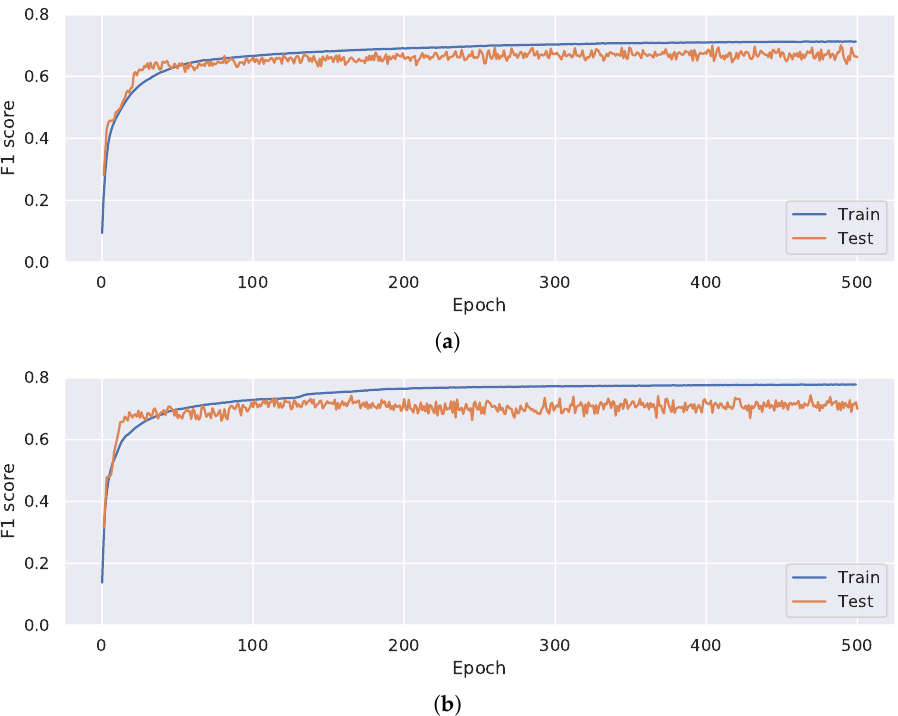
Figure 3. Custom CNN score evolution on training and test subsets. ( a ) Window size 128. ( b ) Window size